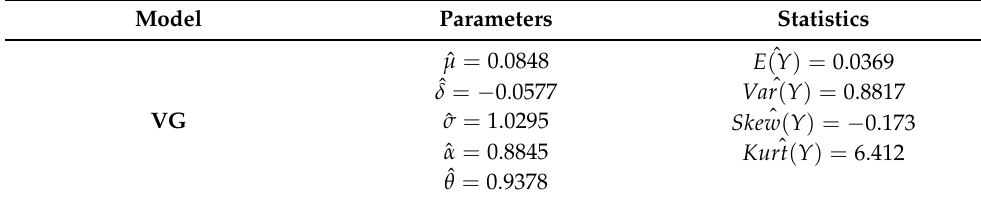
Table 1. FRFT Maximum Likelihood VG parameter estimation.